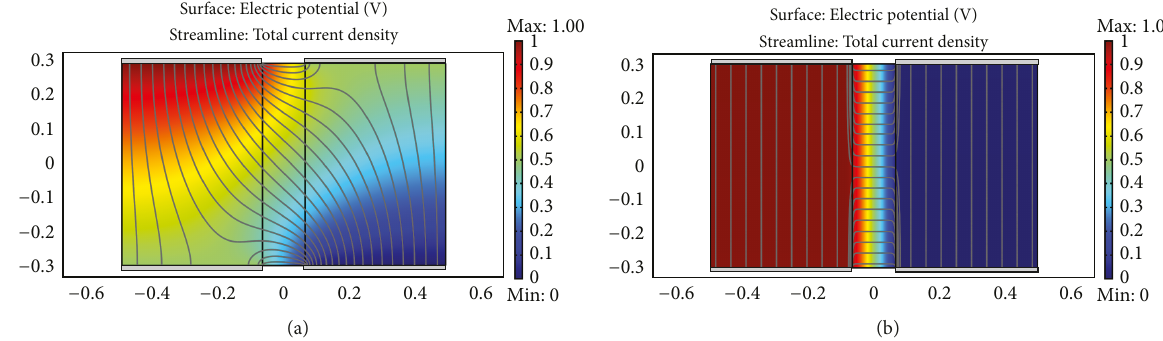
Figure9:RectangulardevicefromFigure6with 𝑊 0 = 0.62207 m, 𝑠 0 = 0.13149 mforcomparisonoftheanalyticaltheorywithafiniteelement simulation with COMSOL MULTIPHYSICS. The plots show the potential and current streamlines. (a) The left plot is for small mechanical stress difference 𝜎 𝑥𝑥 − 𝜎 𝑦𝑦 (third line of Table 1); (b) the right plot is for large mechanical stress difference (last line of Table